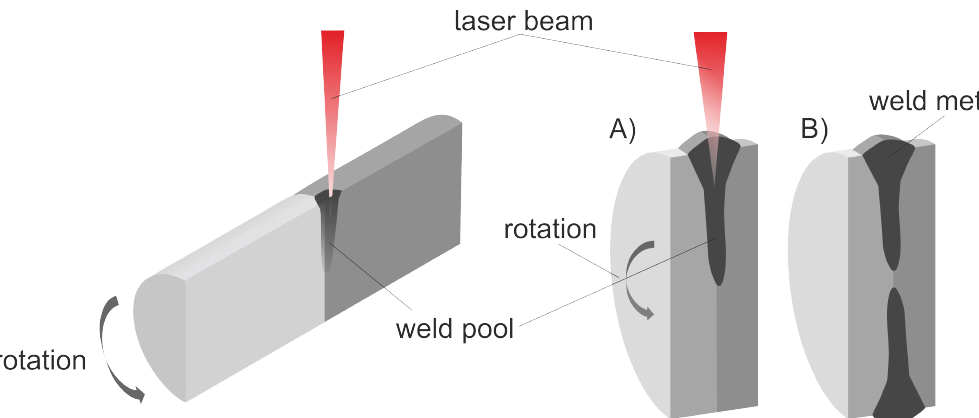
Figure 1. Left: Schematic drawing of the welding process, right: schematic drawings of the sample geometries in cross section while ( A ) and after ( B )